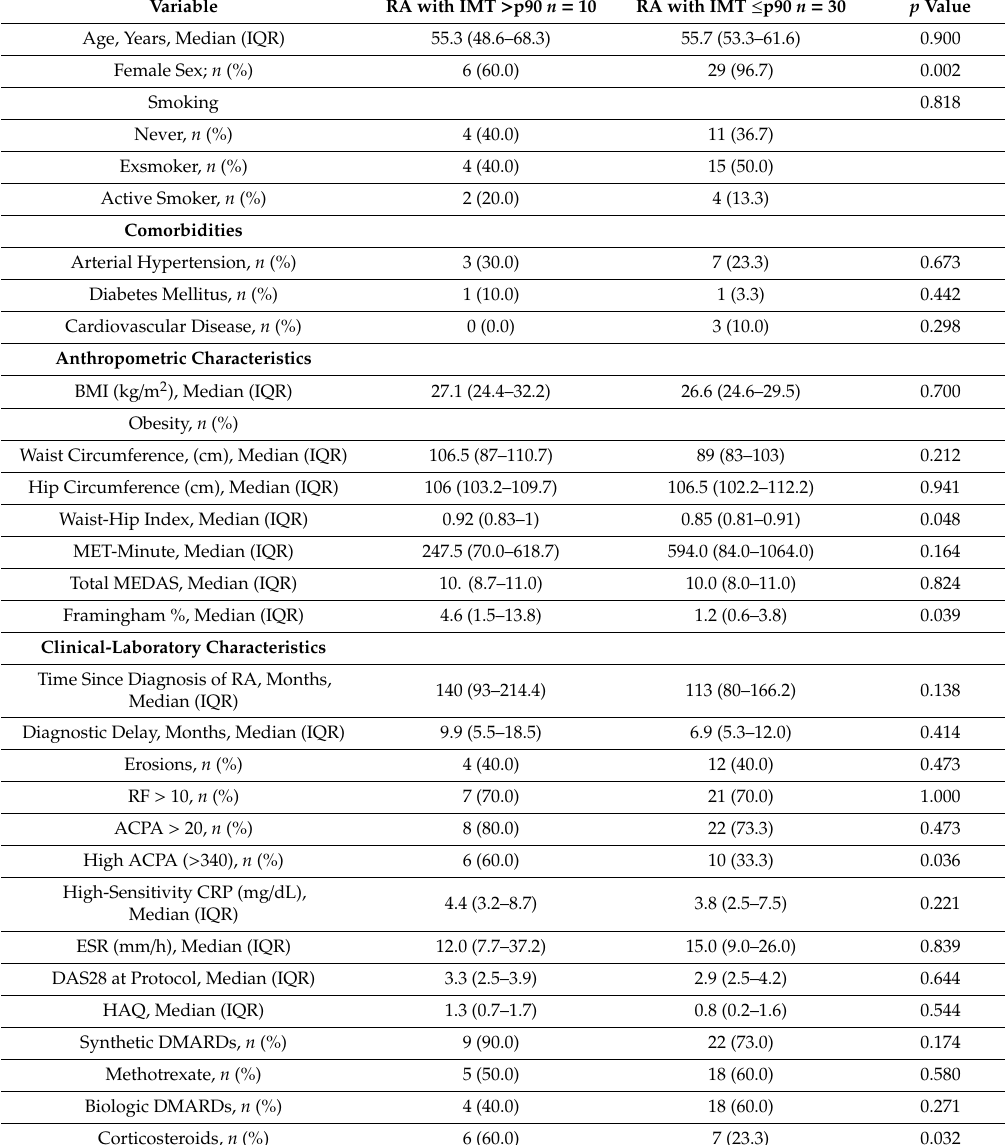
Table 3. Baseline characteristics of patients with RA according to